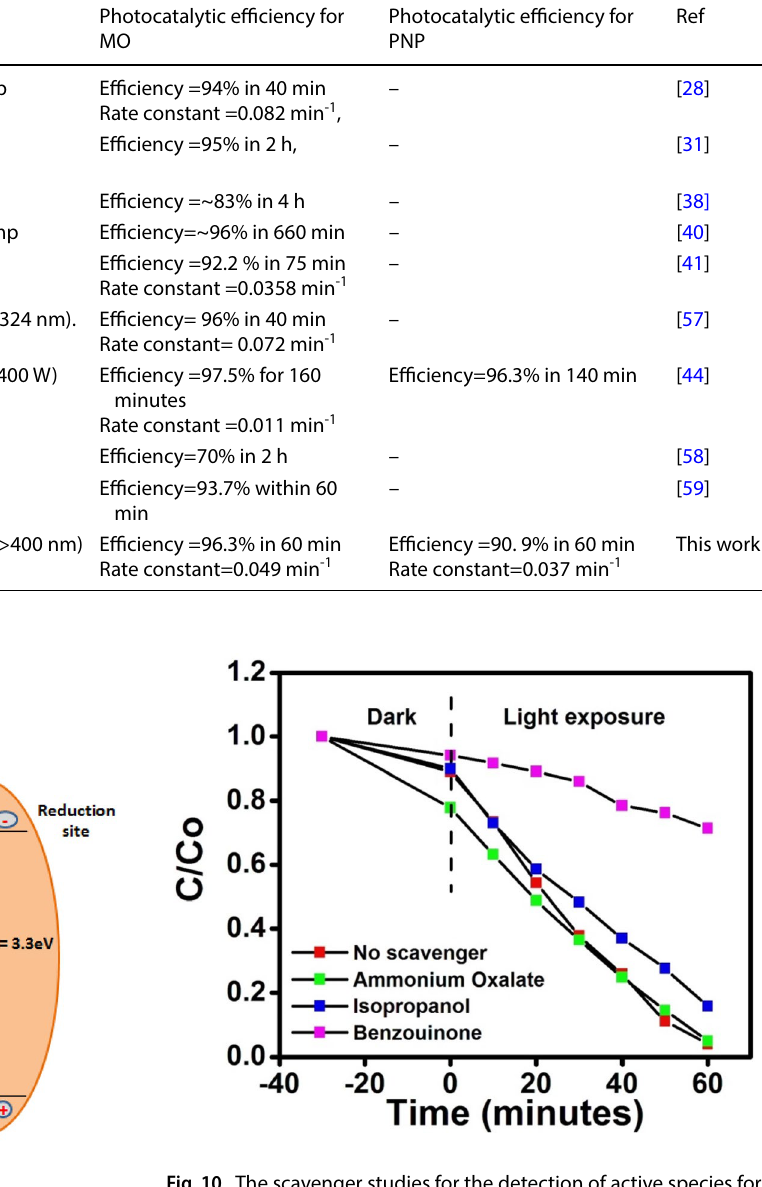
Fig. 9 Schematics for the electron and hole transfer in the ZnO– ZnS heterostructures